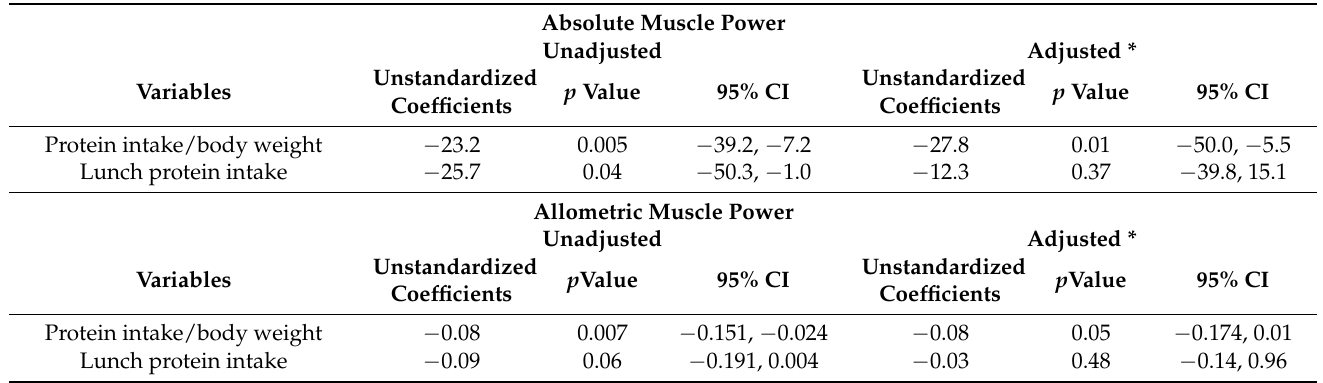
Table 3. Linear regression analysis for the association between muscle power and protein-related parameters (n =